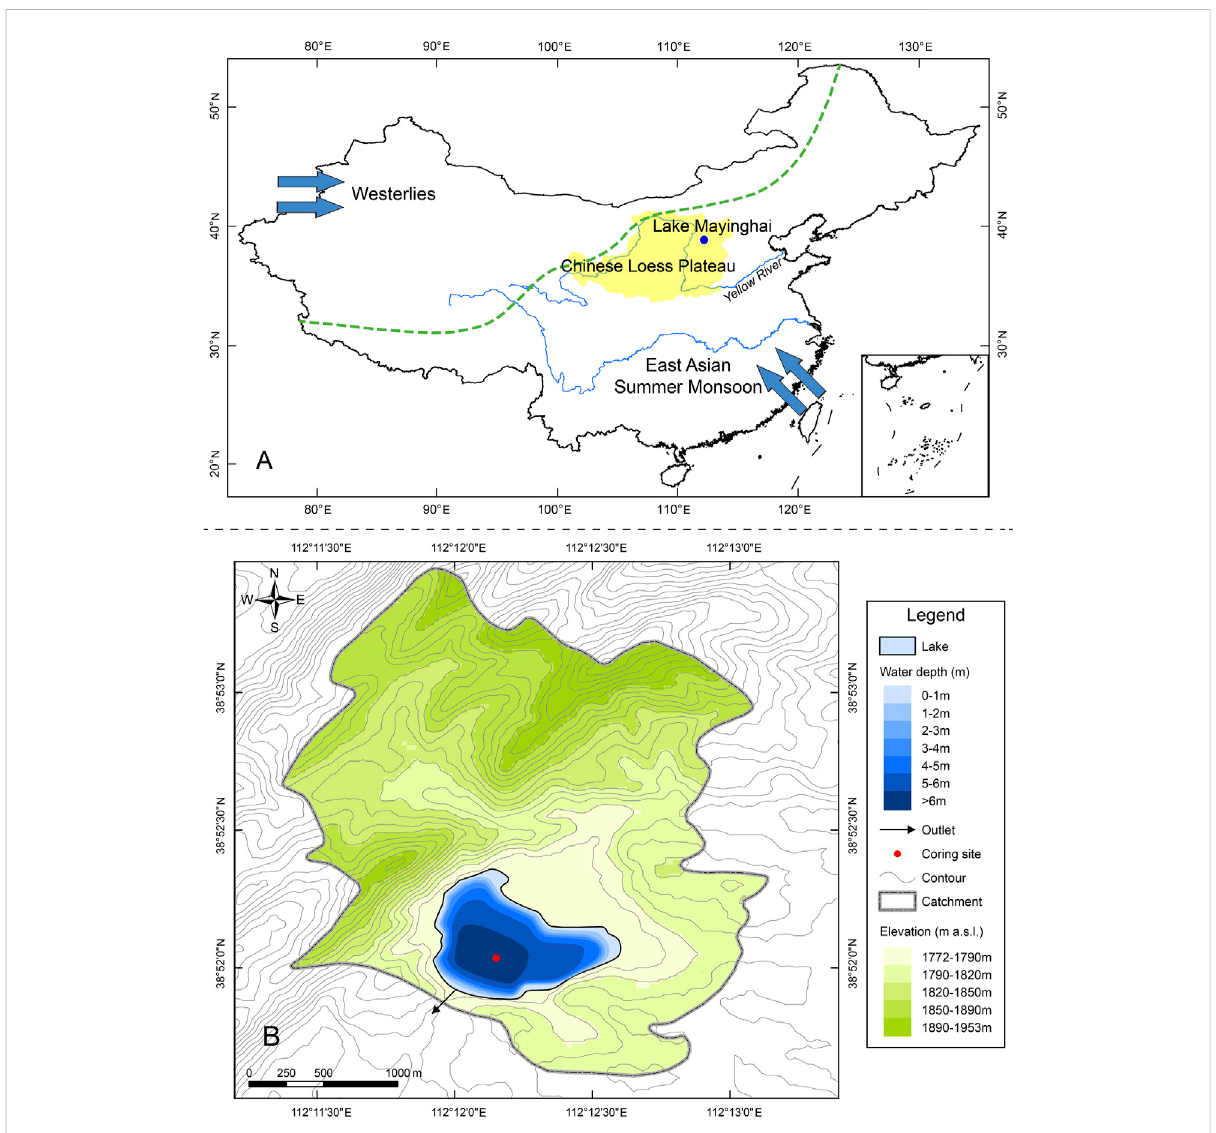
FIGURE 1 The geographical background of Lake Mayinghai. (A) Map of China showing the location of Lake Mayinghai (blue dot) on the Chinese Loess Plateau, which is in the northern East Asian summer monsoon region, with the green dashed line indicating the modern boundary between the East Asian summer monsoon and the westerly climate systems. (B) Map of Lake Mayinghaishowing the lakebathymetry with the coring site (red dot) and the 10 m-interval contour topography of its catchment and surrounding